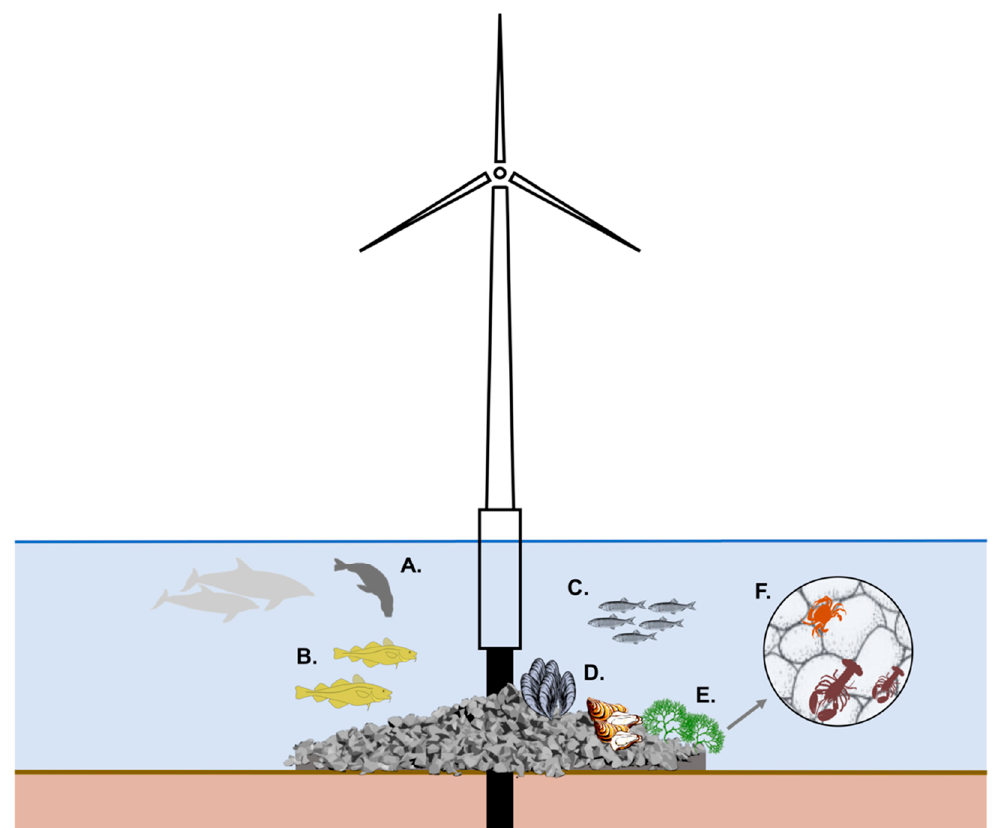
Figure 7. Conceptual illustration of offshore wind turbine and proposed ecological functions of scour protection. Reviewed evidence reveals that scour protection may provide food, shelter and reproduction grounds for fish, as well as settlement grounds for bivalves and macro algae. Examples show species that could benefit from improved scour protection designs: ( A ) Marine mammal feeding grounds [134]; ( B ) Atlantic cod, utilizing scour protection structures [71]; ( C ) Atlantic herring, utilizing scour protection for spawning [89]; ( D ) Mussel and oyster banks [135]; ( E ) Macro algal restoration [136,137]; ( F ) Shelter for shellfish